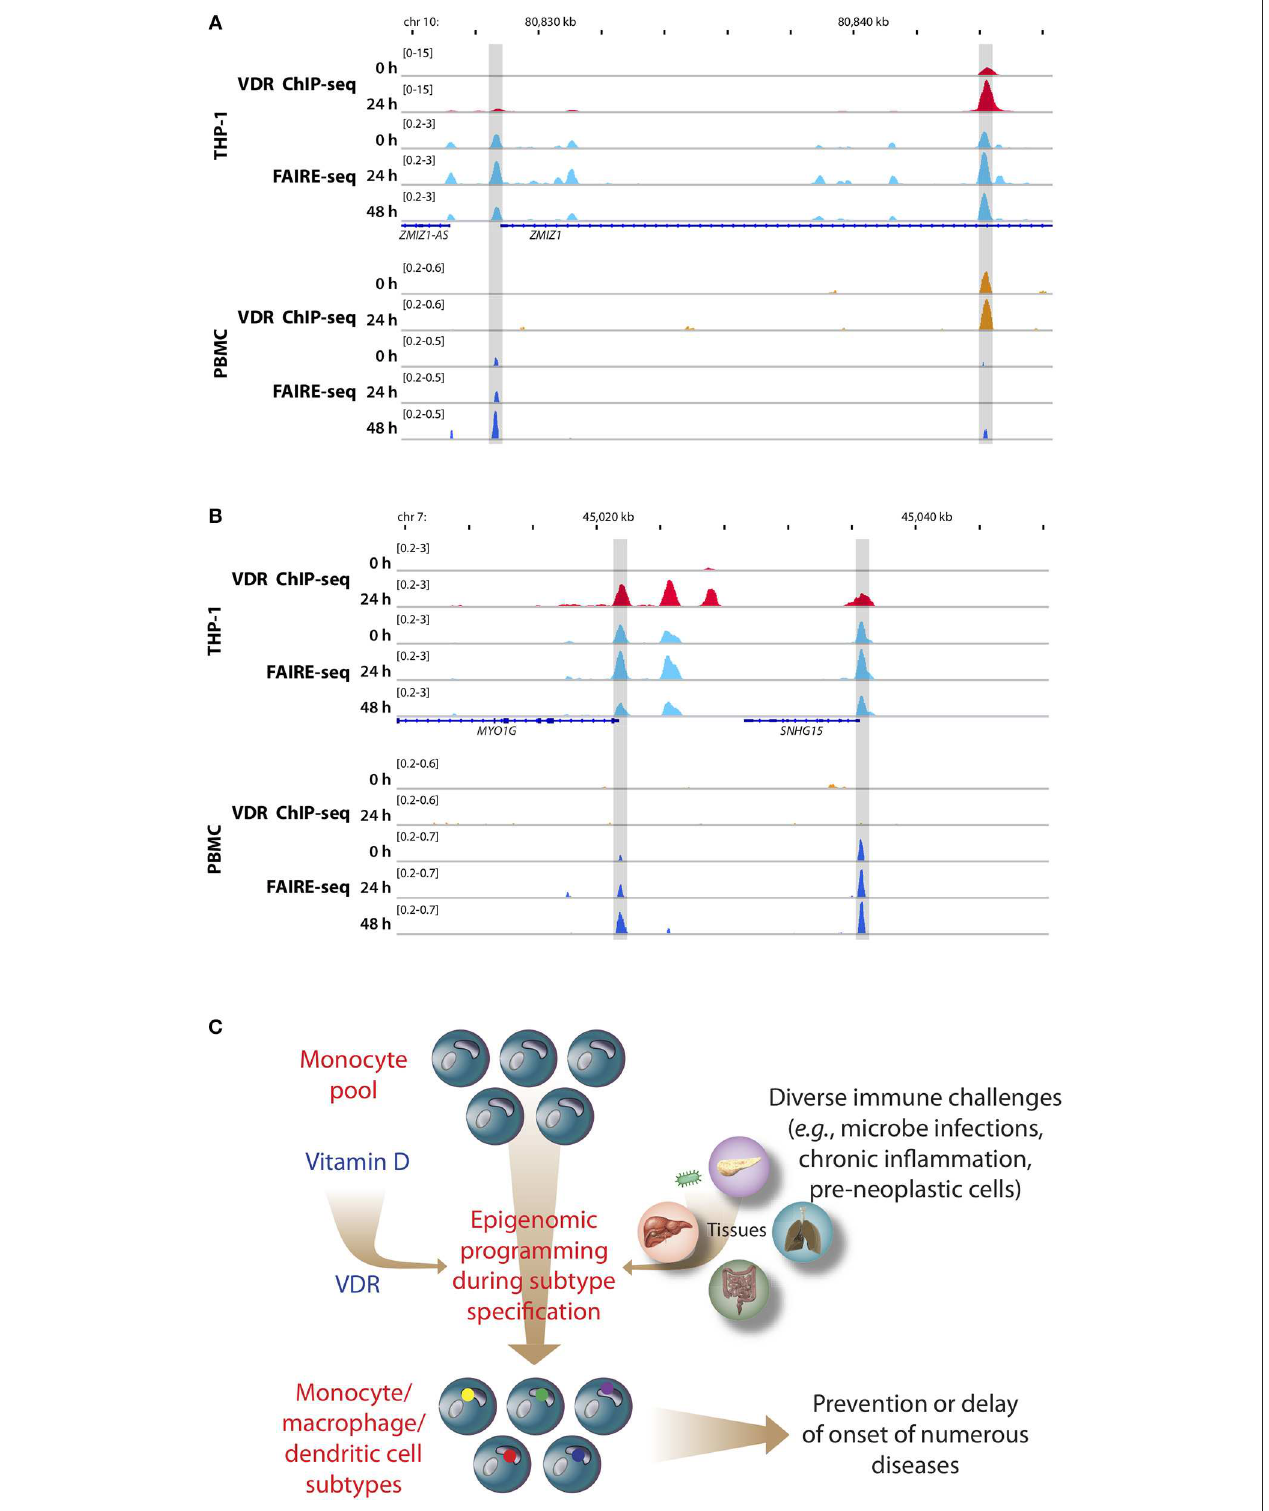
FIGURE 2 | Memory hypothesis. VDR binding and chromatin opening of the loci of the genes ZMIZ1 , (A) and MYO1G (B) in vitro (THP-1) as well as in vivo (PBMCs). THP-1 cells were stimulated for 0, 24, and 48h with 1,25(OH) 2 D 3 and VDR ChIP-seq and FAIRE-seq were performed (22). In a comparable in vivo experiment an